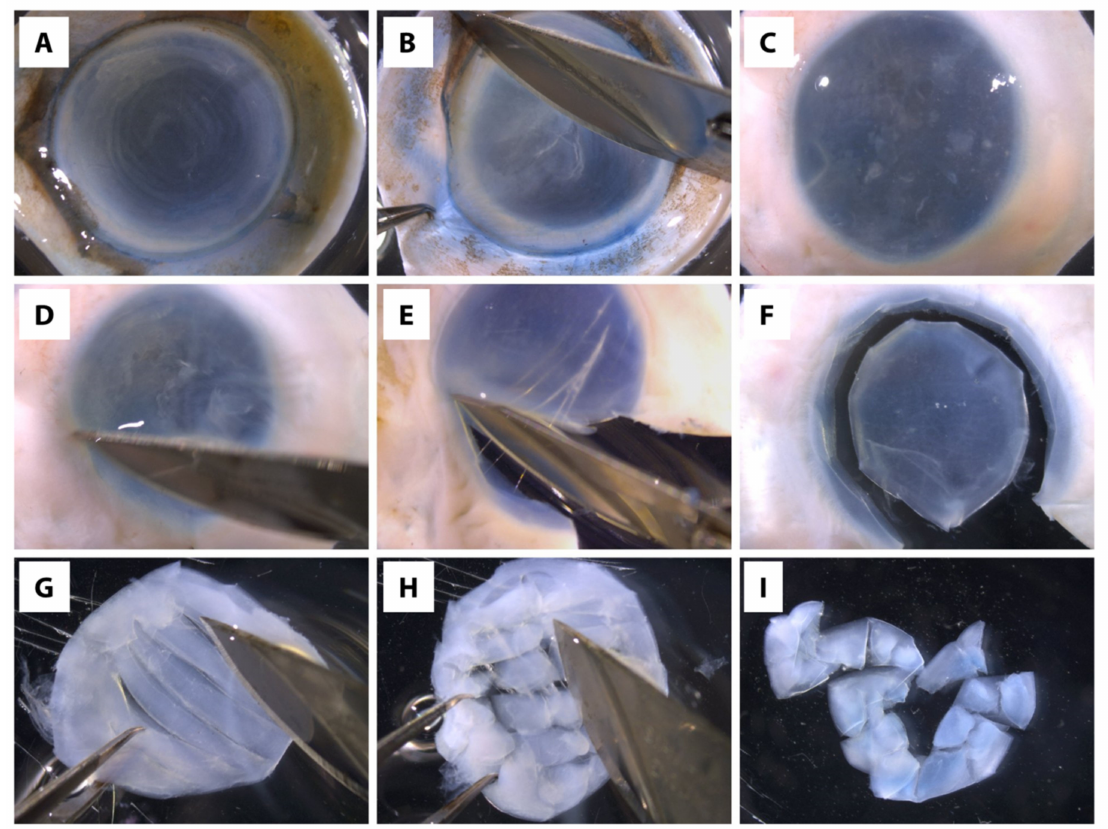
Figure 2. Still photographs of the human corneal tissue dissection. ( A – D ) The first dissection steps involve the removal of the corneal epithelial and endothelial cells, and trabecular meshwork from the corneas, by scraping with a surgical blade no. 10. ( E , F ) The corneal stroma is then separated from the scleral tissue by cutting ~2 mm from the sclera. ( G – I ) Finally, the corneal stroma is cut into smaller pieces by leaving the edges of each piece still attached to the adjacent